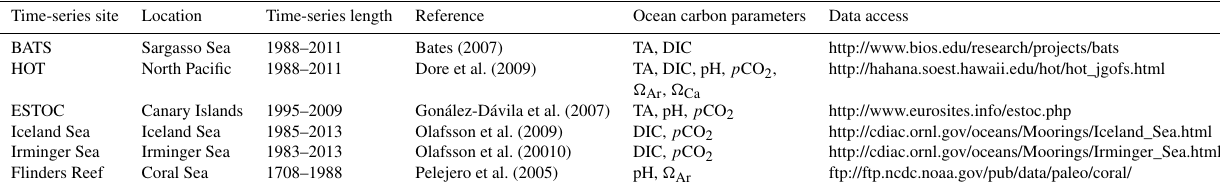
Table 3. Observational time-series information and carbonate parameters from each location.